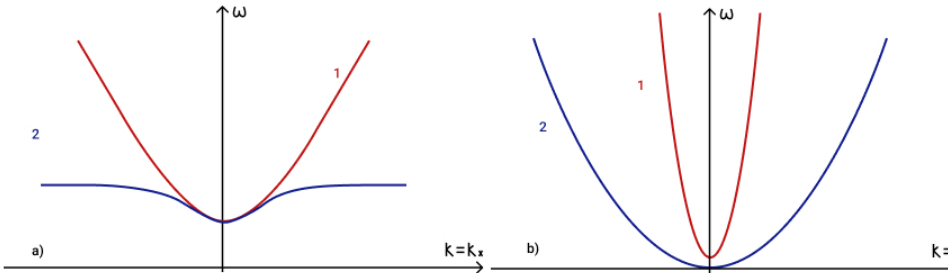
Figure 21. Dispersion curves for 1—magneto-Poincare ω mP and 2—magnetostrophic waves ω ms ( a ) in an external vertical magnetic field and ( b ) in a horizontal magnetic